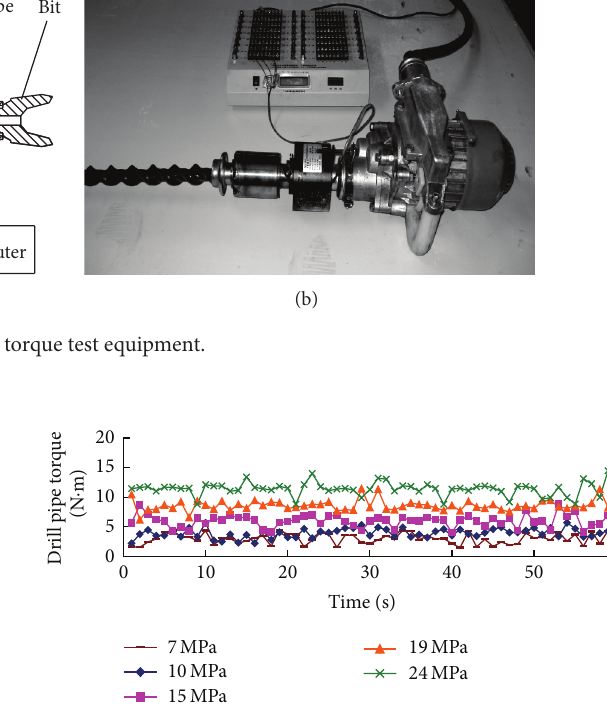
Figure4:Historytimecurveofdrillpipetorqueunderdifferentcoal stress.